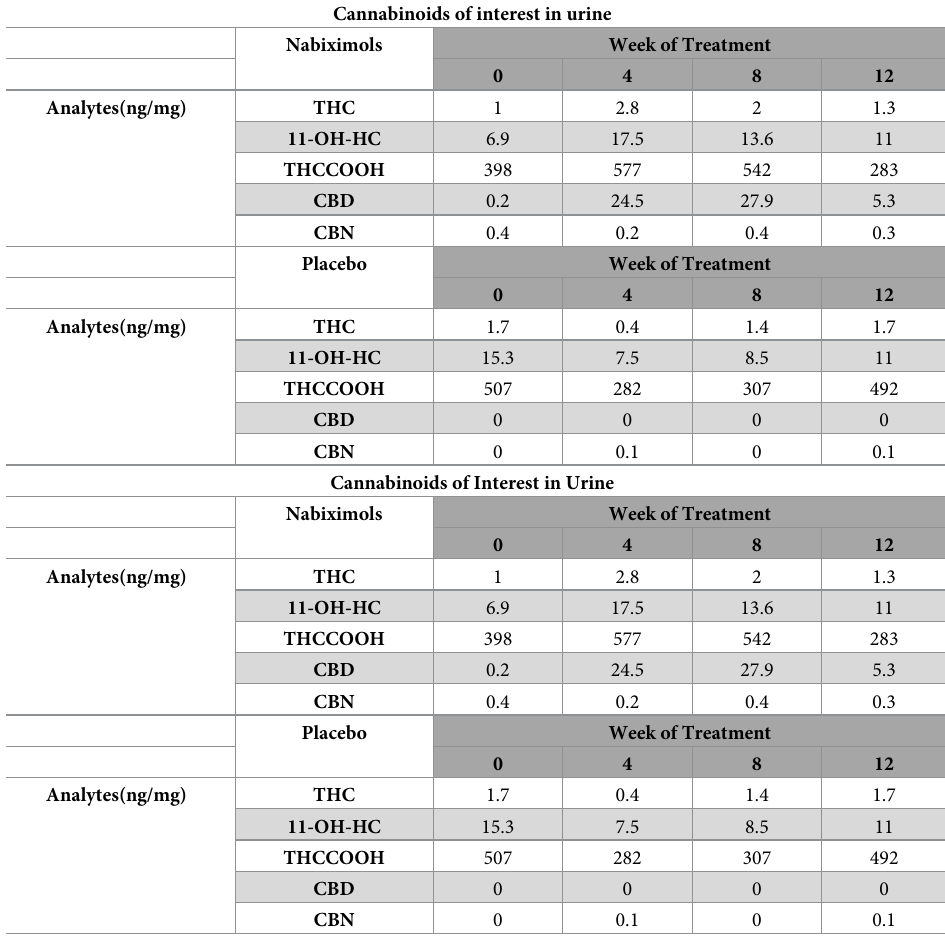
time (F = 3.699, p < .05) and treatment (F = 6.573, p < .05) and a significant time x 3,69.6 1,24.6 treatment interaction (F = 3.699, p < .05). Concentrations of CBD went up to 28 ng/mg at 3,69.6 week 8 of treatment with nabiximols but were barely above the limit of quantification in the placebo group. On the other hand, no significant effects of time or treatment with nabiximols (THCCOOH) and cannabinol (CBN) concentrations.